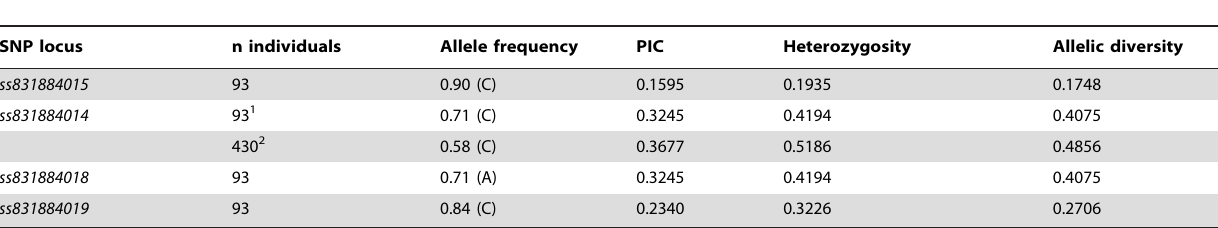
Table 2. Allele frequencies, polymorphism information content (PIC), heterozygosity and allelic diversity for four allelic variants in the amh gene detected in a genetically all-female (XX) Nile tilapia